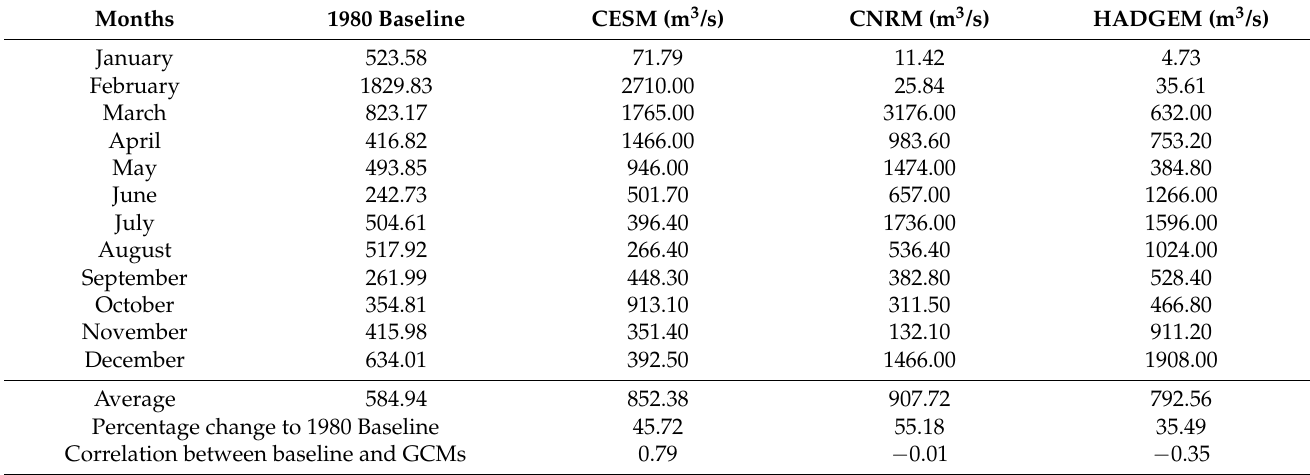
Table 7. Comparison of simulated 1980 baseline monthly streamflow (m 3 /s) to 2075 streamflow from the different